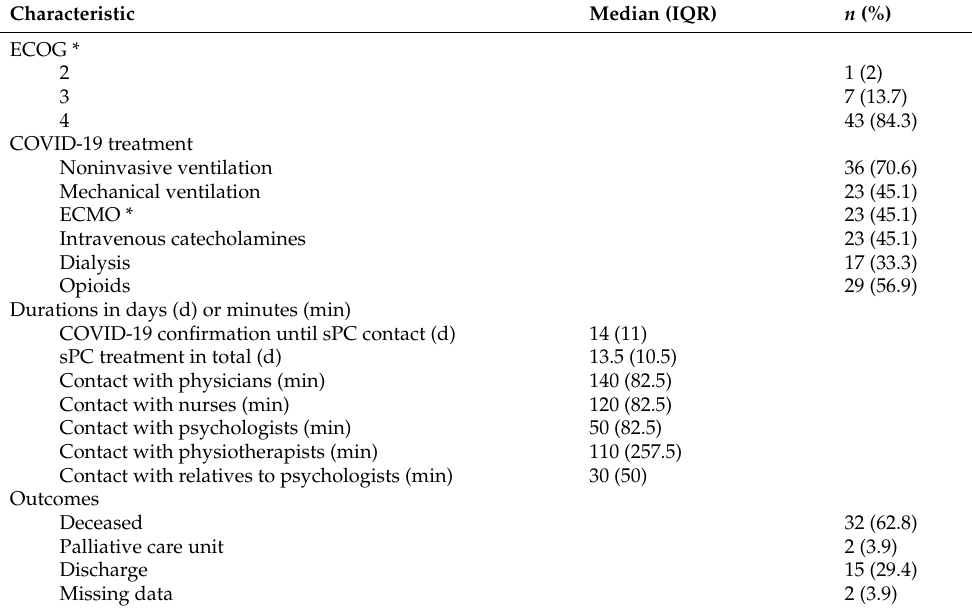
Table 2. Performance status at first specialist palliative care (sPC) contact, COVID-19 treatment, sPC involvement and outcomes in COVID-19 patients in the intensive care unit receiving